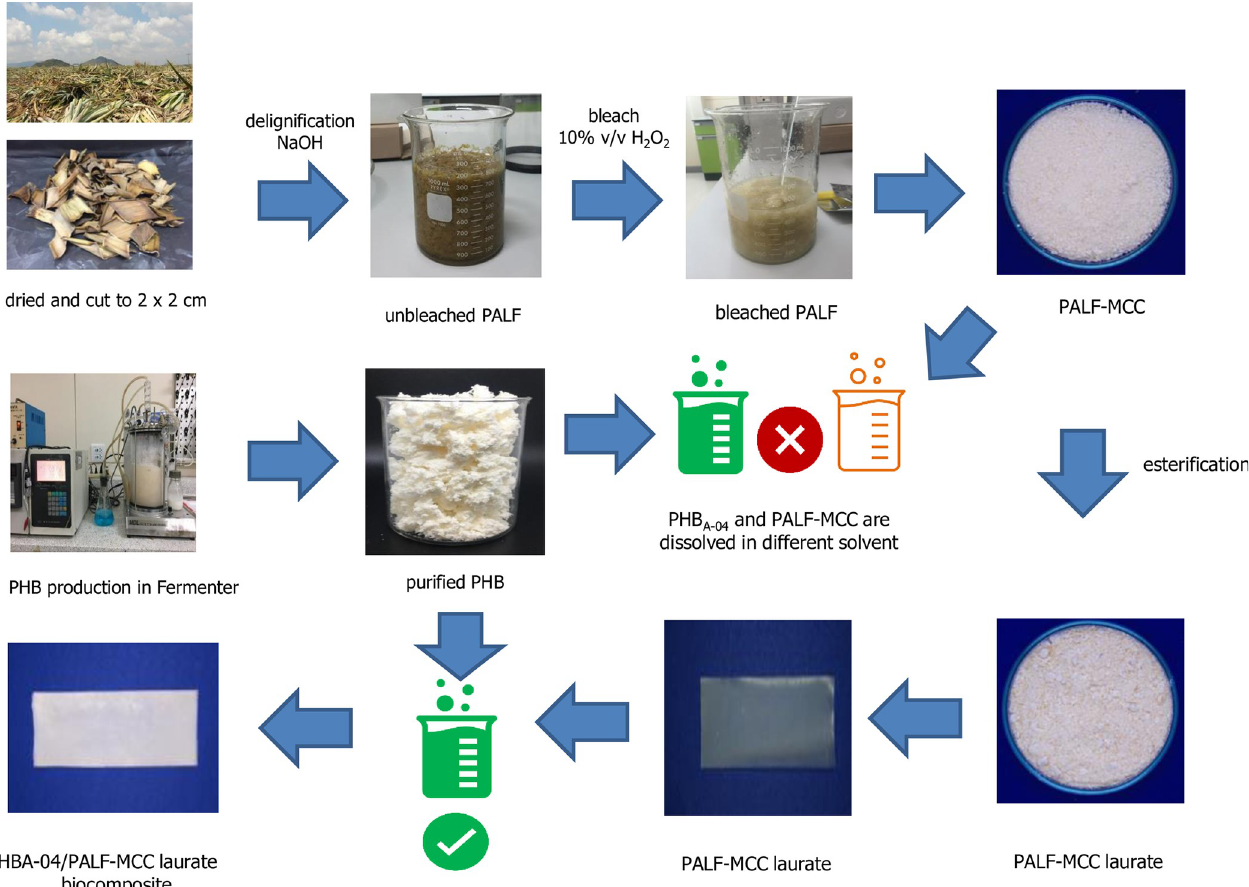
Fig 2. Schematic diagram for the preparation of esterified PALF-MCC laurate to depict the method for preparing fibres to be compatible with solvent casting PHB A-04